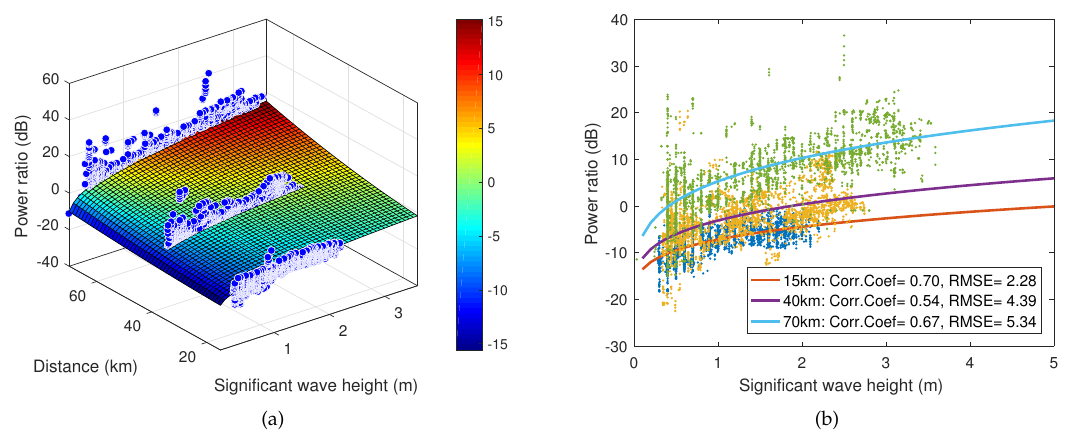
Figure 9. Fitting results of Bragg power ratio with respect to wave height h s and distance R . ( a ) Surface view along h s and R . ( b ) Curve view along h s .